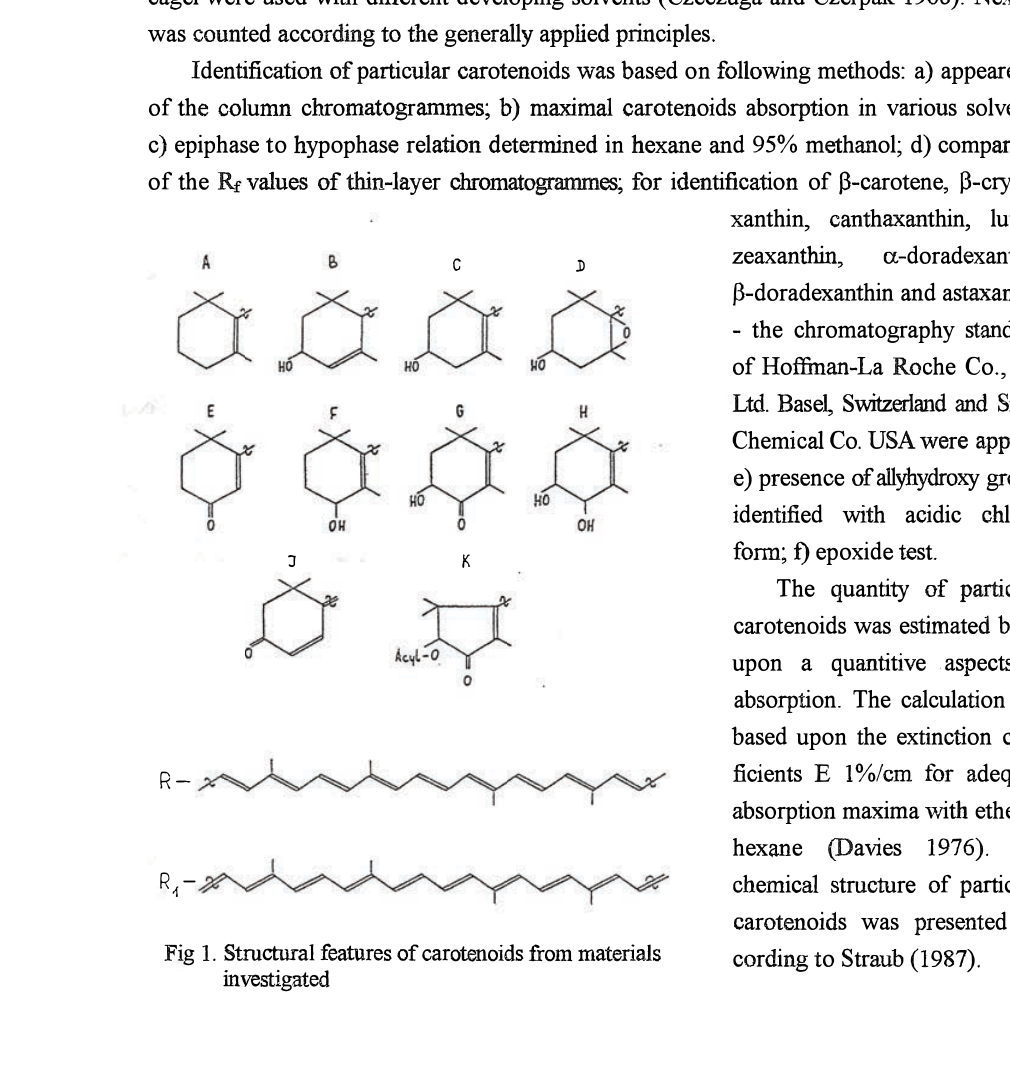
Fig 1. Structural features of carotenoids from materials